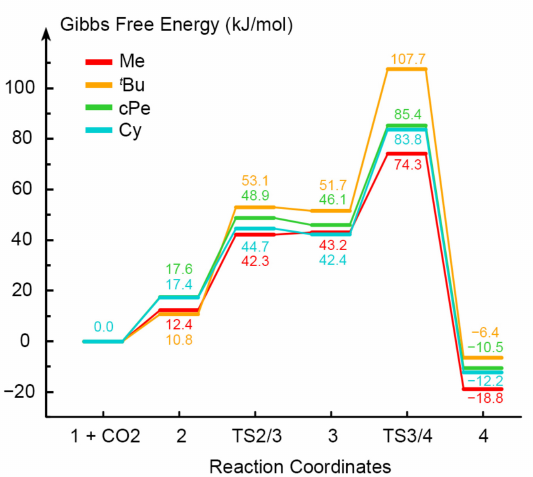
Figure 7. Free energy profiles of the total reaction of CO 2 hydrogenation on R-substituted (R = Me, t Bu, cPe, Cy) complexes.